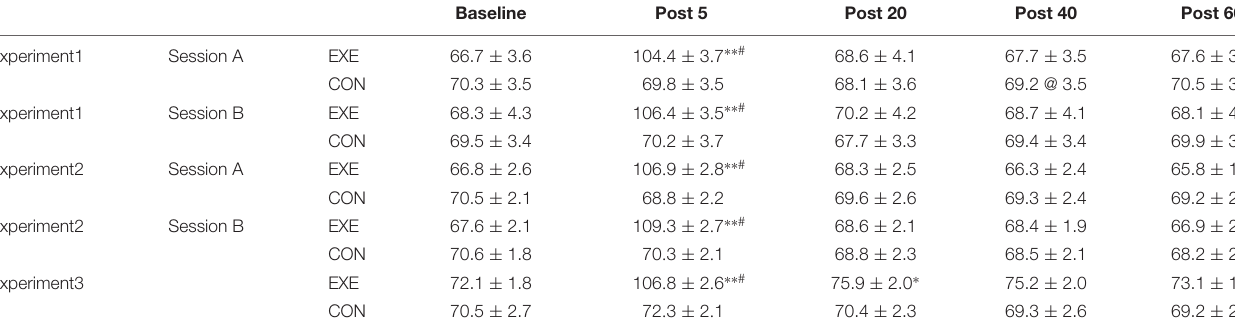
TABLE 2 | Changes in heart rate in Experiments